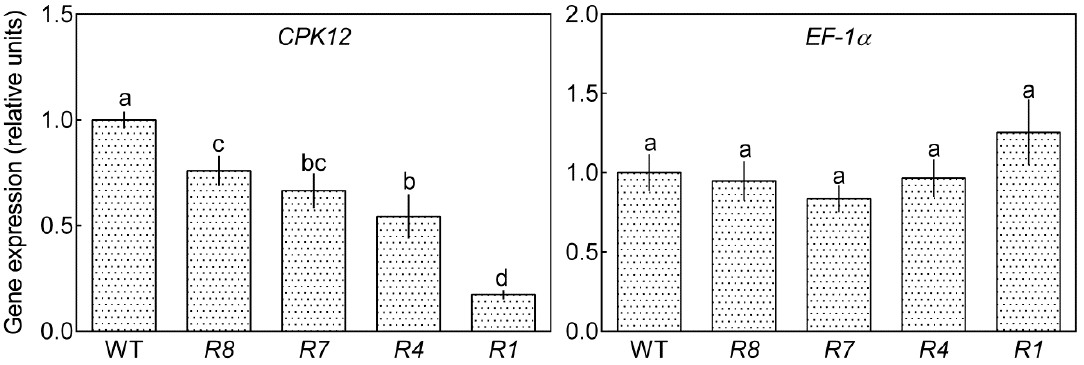
Figure 1. The expression of CPK12 ( Ca 2+ -Dependent Protein Kinase 12 ) and EF-1 α ( Elongation Factor-1 α ) in WT and CPK12 -RNAi mutant. The mRNA levels (relative units, normalized relative to the mRNA level of the wild-type GL1 taken as 100%) of CPK12 and EF-1 α , estimated by qRT-PCR, in the non-transgenic GL1 (WT) and four different transgenic CPK12 -RNAi lines (indicated by R8 , R7 , R4 , and R1 ). Values are mean ± standard error from three independent experiments. Columns labeled with different letters indicate significant differences at p < 0.05.